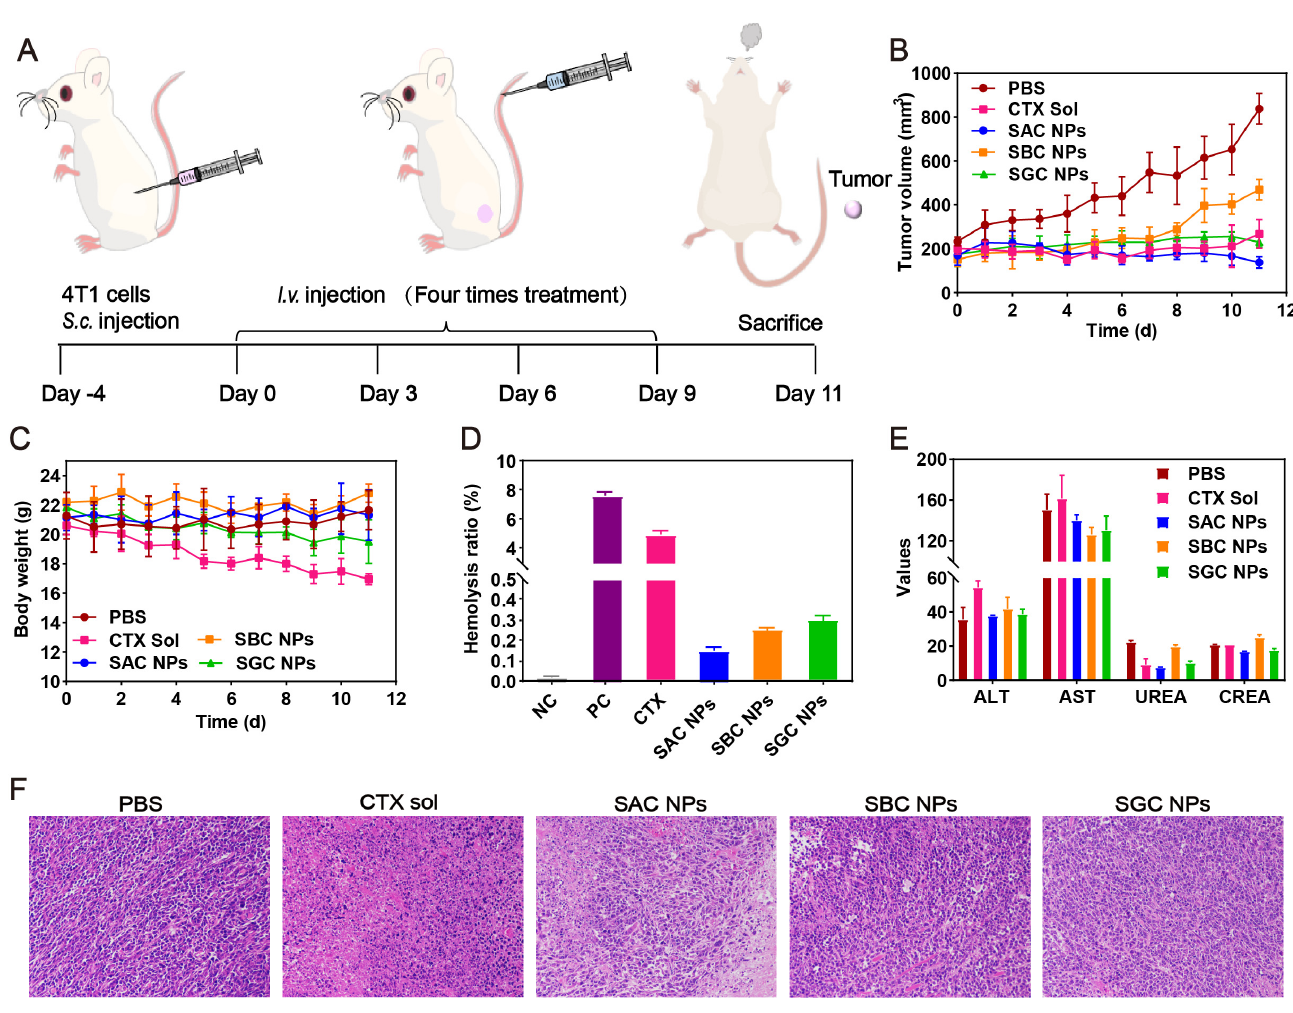
Figure 5. In vivo antitumor evaluation in the 4T1 tumor model ( n = 5). ( A ) Treatment schedule; ( B ) Tumor growth curves; ( C ) Body weight of mice during treatment; ( D ) Hemolytic activity; ( E ) Hepatorenal function parameters; ( F ) Representative H&E − staining of tumors of varied groups.